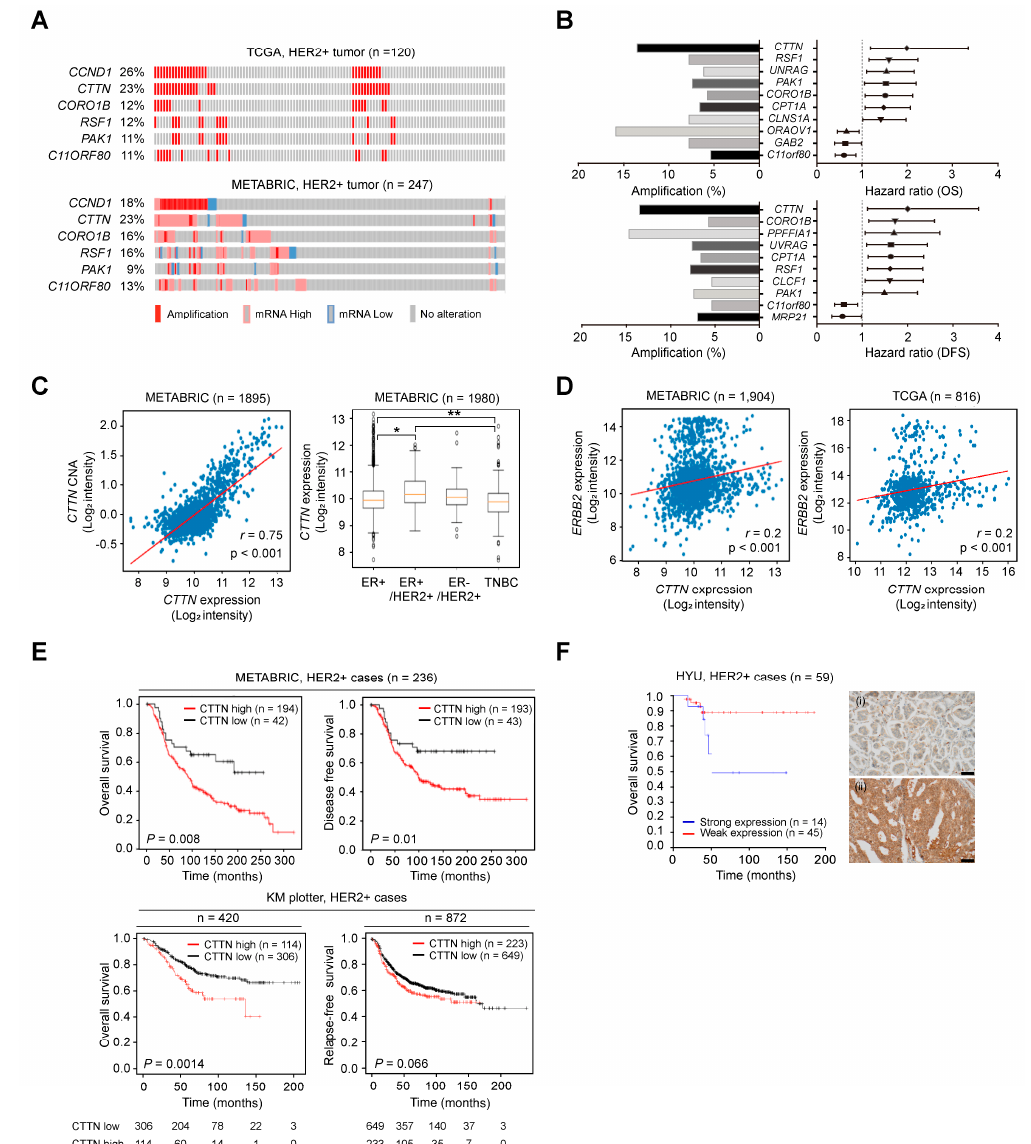
Figure 1. Genetic alterations of CTTN and their clinical impact in HER2 positive breast cancer. ( A ) Oncoprints representing the gene amplification and expression levels of genes at 11q13 in the indicated breast cancer datasets. ( B ) Forest plots representing the hazard ratios (HRs) of genes located at 11q13 according to the overall survival (OS) ( top right ) and disease-free survival (DFS) ( bottom right ) of HER2+ breast cancer patients from the METABRIC dataset. Genes in 11q13 were nominated based on hazard ratios (CTTN, HR (OS), 1.994; p = 0.009, HR (DFS), 2.005; p = 0.018). Bar graphs represent the percentage amplifications of the indicated genes ( left ). ( C ) Scatter plot displaying the correlation between copy number alteration (CNA) and expression of CTTN in METABRIC ( left ). Pearson’s correlation coefficient was used to determine r values. The box plots display CTTN mRNA levels in selected subtypes from METABRIC ( right ). The vertical bars from the boxes (whiskers) indicate lowest and highest values. The horizontal lines (red) inside the boxes indicate medians. The 25th and 75th percentiles are represented by the bottom and top of the boxes, respectively. p -values were determined by one-way ANOVA followed by post hoc Tukey tests. * p < 0.05, ** p < 0.01 ( D ) Scatterplots displaying the correlation between expression of CTTN and HER2. Pearson’s correlation coefficient was used to determine the r value. p -values were determined by one-way ANOVA with post hoc LSD tests. ( E ) Using the Kaplan–Meier method and the log-rank test, the survival of HER2+ breast cancer patients was analyzed based on CTTN expression in METABRIC ( top ) and KM